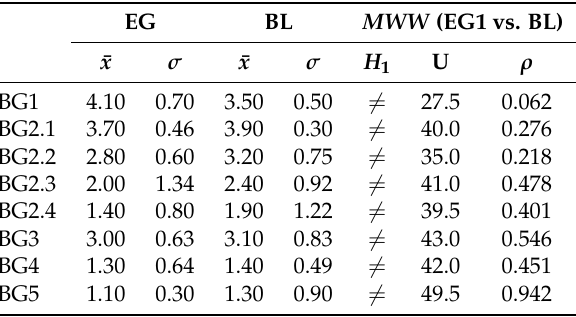
Table 1. Summary of the results of the background questionnaire between the BL and EG groups, including the values of the non-parametric significance Mann–Whitney–Wilcoxon ( MWW ) test.